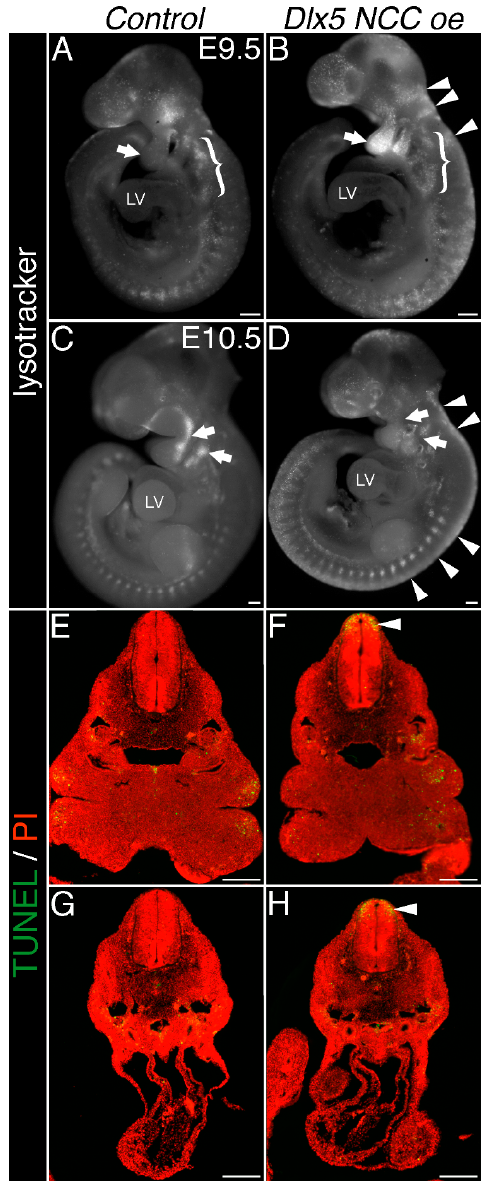
Figure 5. Lysotracker and Terminal deoxynucleotidyl transferase. dUTP nick end labeling (TUNEL) staining of Dlx5 NCC oe embryos. ( A ) E.9.5 control embryo showing normal cell death within the head and tissues dorsal to the OFT (brackets). No significant apoptosis is observed within the first and second pharyngeal arches (arrow). ( B ) E9.5 Dlx5 NCC oe embryo showing visible cell death within the neural tube (arrowheads) and, most notably, within the first and second pharyngeal arches (arrow). ( C ) E10.5 control embryo showing normal cell death. Arrows denote cell death within the proximal rostral pharyngeal domain of the first and second pharyngeal arches. ( D ) E10.5 Dlx5 NCC oe embryo showing persistent dorsal neural tube cell death, whereas first and second pharyngeal arches show less apoptosis than controls. ( E ) and ( F ) E10.5 TUNEL stained control and Dlx5 NCC oe embryos. Elevated cell death within the neural tube of Dlx5 NCC oe embryos is clearly visible (arrowhead), as are the hypoplastic first and second pharyngeal arches. ( G , H ) more caudal sections showing minimal cell death within the cardiac OFT in control and Dlx5 NCC oe embryos. Scale bars = 200 µ